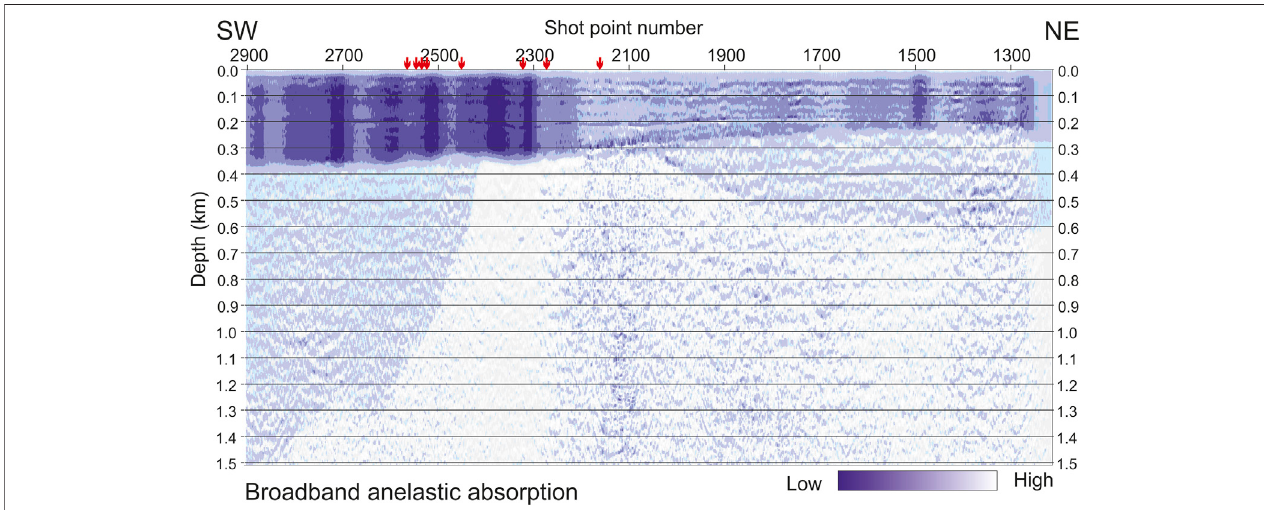
FIGURE 14 | Broadband anelastic absorption, obtained combining the low-pass fi ltered tomographic component in Figure 8 with the high-pass fi ltered from the instantaneous-frequency component ( Figure 6 ). The small red arrows on top indicate the proximity of known plume areas.